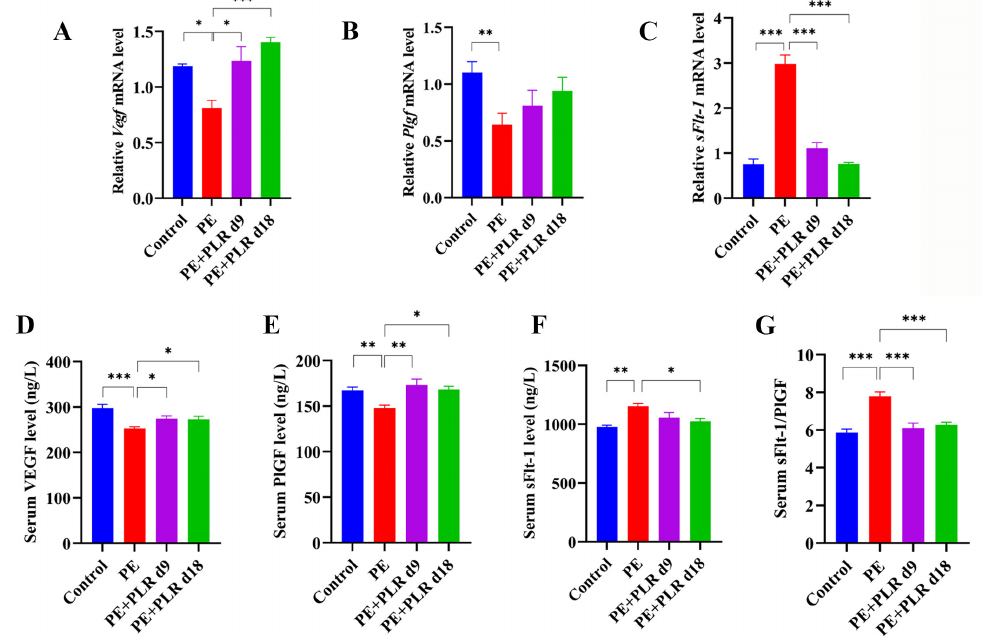
Figure 2. PLR reversed the angiogenic imbalance in PE mice. ( A – C ) Relative mRNA levels of Vegf , Plgf , and sFlt-1 in placenta. ( D – F ) Serum levels of VEGF, PlGF, and sFlt-1 were measured by ELISA. ( G ) The ratio of sFlt-1 and PlGF was calculated using ELISA results. For ( A – C ), n = 6 for each group. For ( D – G ), n = 8 for each group. Data are expressed as the mean ± SEM. * p < 0.05, ** p < 0.01, *** p < 0.001 (ANOVA test).